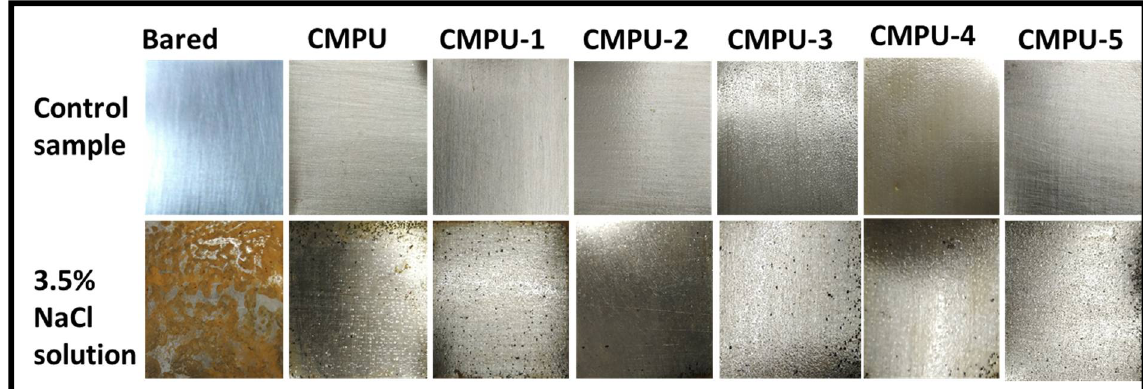
Figure 7. Anticorrosive performance of bared and prepared PU coatings.